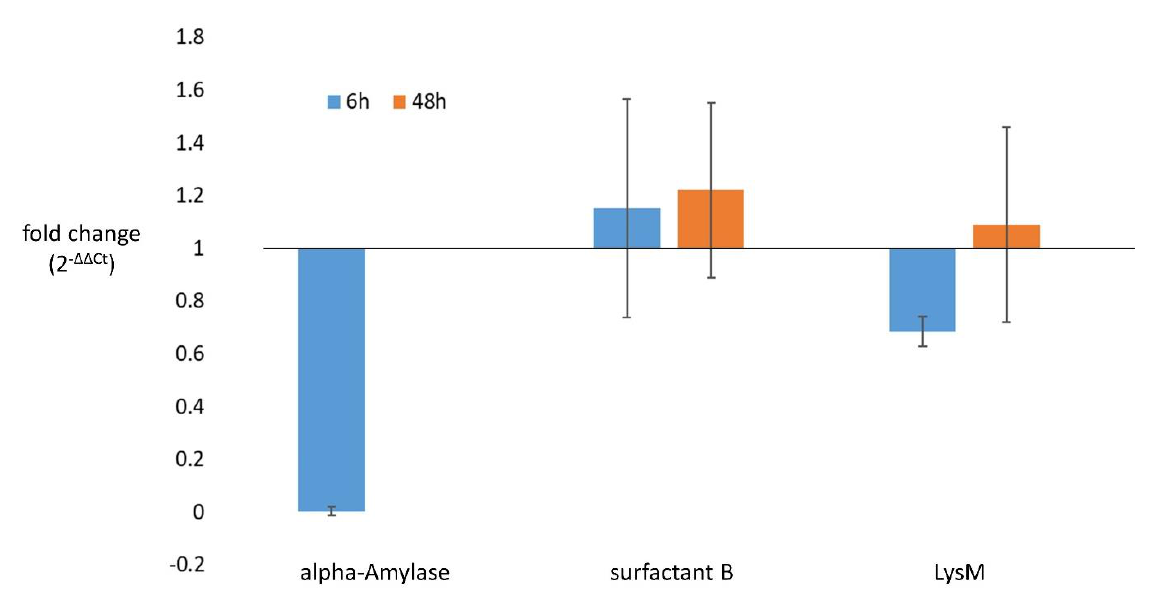
Figure 8. Expression pattern of alpha-amylase, surfactant B and LysM at 6 and 48 h of growth. Gene expression levels for the attenuated and virulent strains were compared at 6 and 48 h of growth. Fold change values were determined with the ∆∆ Ct method in which the attenuated strain was taken as “treated sample” and virulent as “untreated sample” ( ∆∆ CT = ∆ CT (attenuated strain) − ∆ CT (virulent strain), final fold change values were calculated as 2 − ∆∆ CT ).